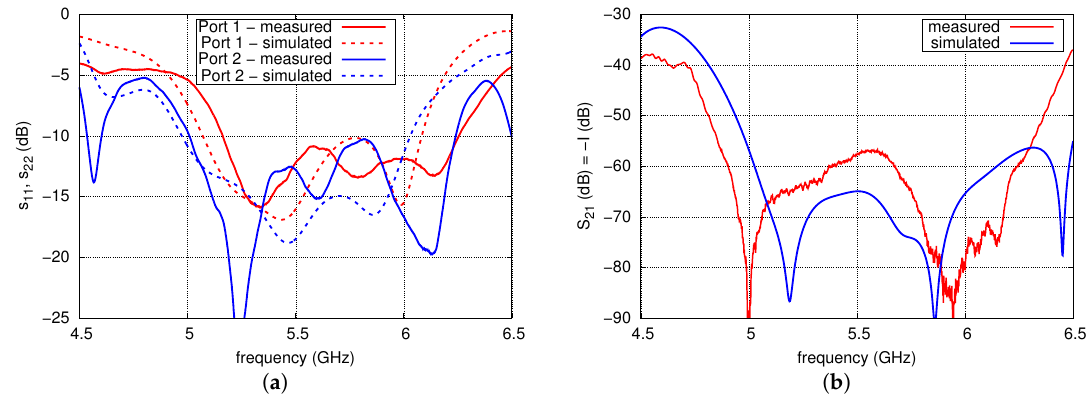
Figure 19. Measured and simulated S-parameters of the antenna array: ( a ) s 11 , s 22 , ( b ) s 21 . Radiation patterns of the antenna array were measured in an anechoic chamber at 5.5 GHz.